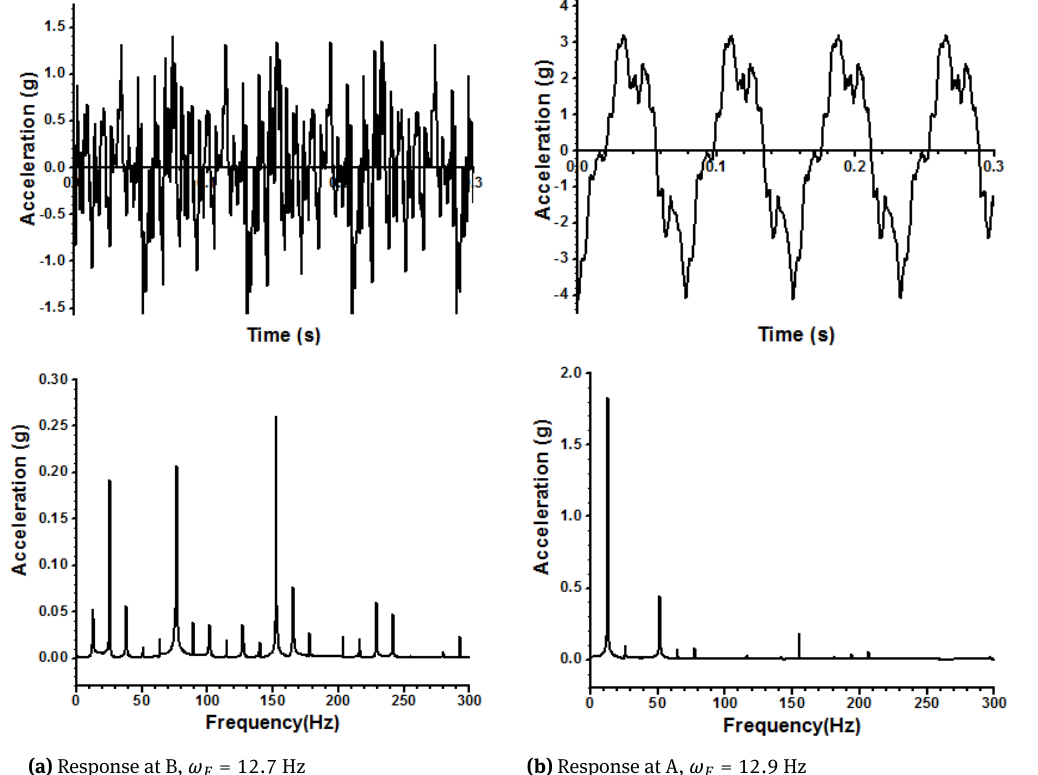
Figure 11: Steady state response history and frequency spectrum of curved beam of span angle 130 ∘ excited at location A (excitation ampli- tude = 0.6